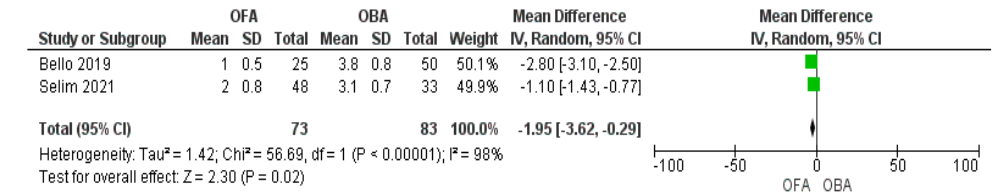
Figure 6. Forest plot of mean difference of pain at 24 h comparing opioid − free anesthesia and opi- oid − based anesthesia [16,17,19].